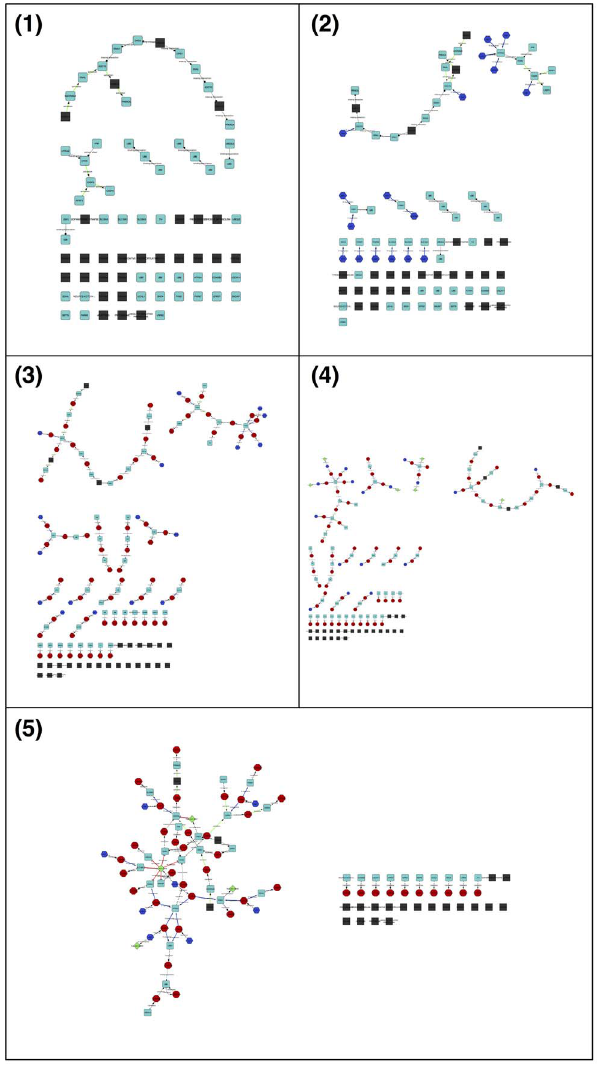
Fig. 5. The image shows the network transformation after each enhancing step. (1) Original KEGG pathway as it appears after parsing of the KEGG Markup Language (KGMML) file. Cyan nodes are genes and black nodes are not-gene entities (i.e., maps, molecular compounds, etc.) (2) Transcription factors enhancing. TFs are formatted as blue hexagonal nodes. (3) Proteins, marked as red circles, are added to the network. (4) miRNAs co-expressed along with their host genes are inserted. miRNAs, marked as green diamonds, have incoming edges originated from their host gene. (5) The enhancing ends with the insertion of edges connecting the miRNAs found in previous step with their target